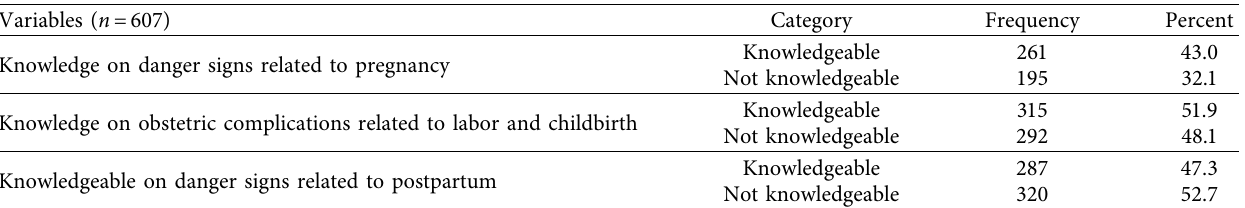
Table 3: Knowledge status of respondents on key obstetric danger signs during pregnancy, labor, and childbirth and after delivery in the Kembata Tembaro zone, 2020.